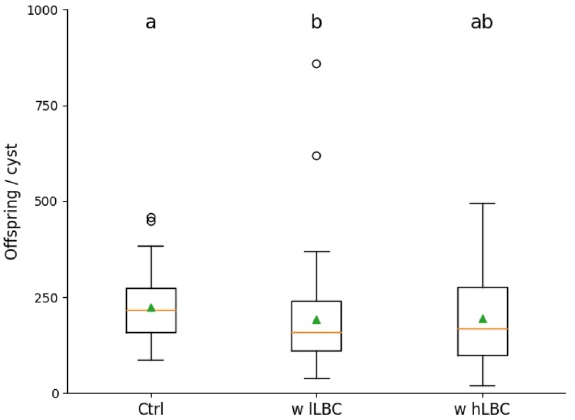
Figure 7. Reproduction assay of Heterodera schachtii at Arabidopsis thaliana roots. Average number of eggs and juveniles per cyst at 35 dpi in the presence of LBC. w hLBC with high number of living bacterial cells, w lLBC with low number of living bacterial cells. Results are expressed as the mean (orange line) and median (green triangle) ± standard error of three independent biological replicates (n ≥ 49). Different letters indicate statistically significant differences among treatments according to Dunn’s Method ( p <